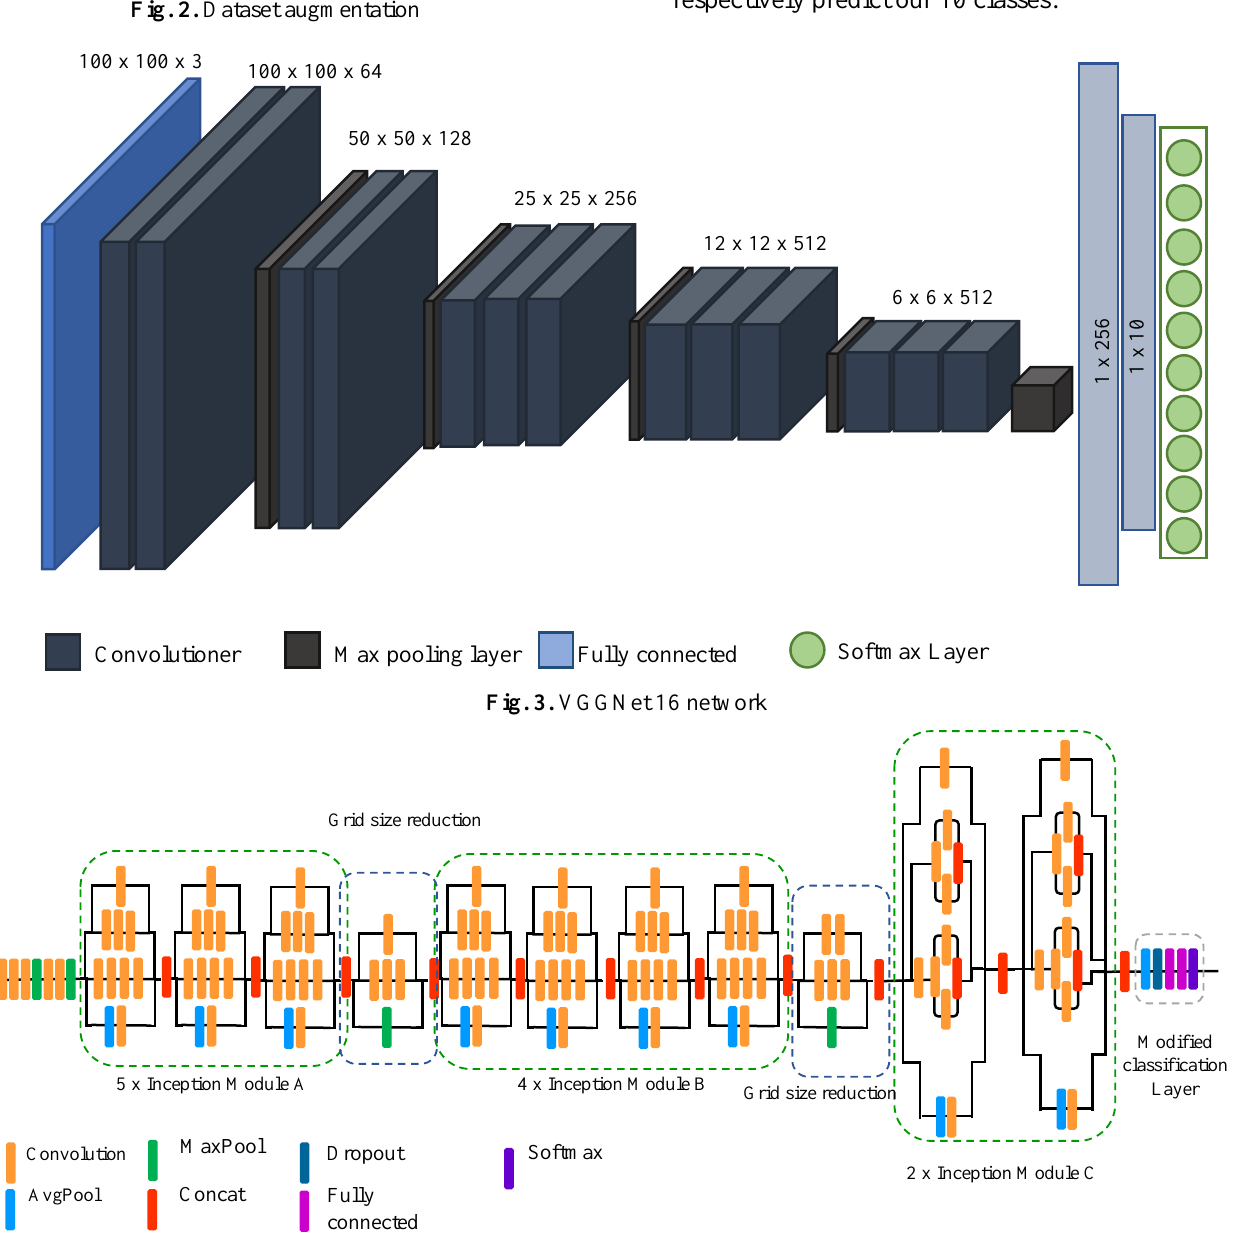
Fig. 4. InceptionV3